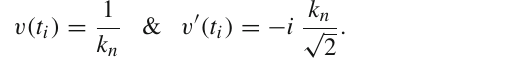
˙ φ( 0 )) } − 1 are shown in Fig. n